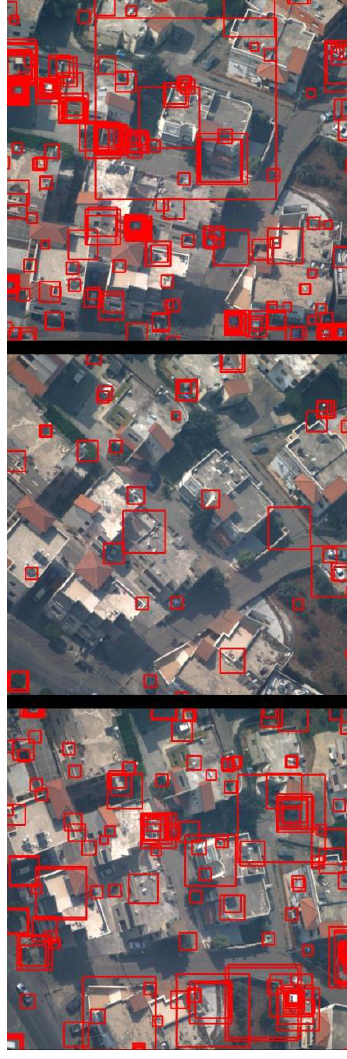
Figure 1: 2D car detections on image with 3 of the 6 orientations